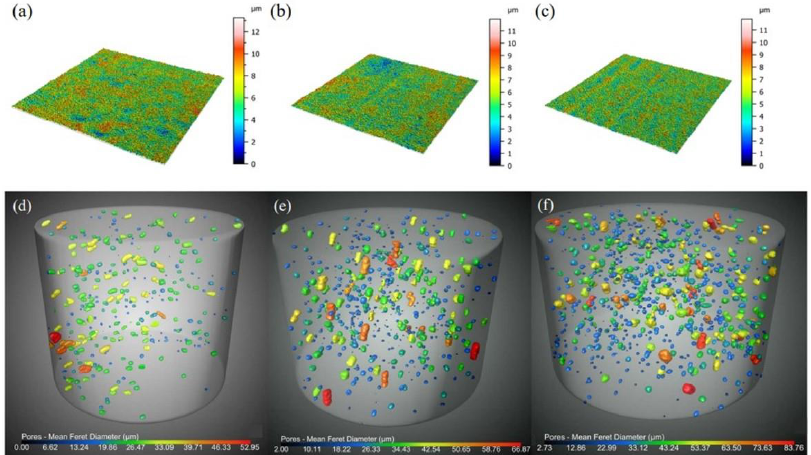
Figure 11. The surface morphologies of ( a ) ZF2, ( b ) ZF5 and ( c ) ZF10 sintered parts, and the com- puted tomography (CT) results of ( d ) ZF2, ( e ) ZF5 and ( f ) ZF10 sintered parts. (The scales in fig- ures(d-f) are only applicable to micropores.)